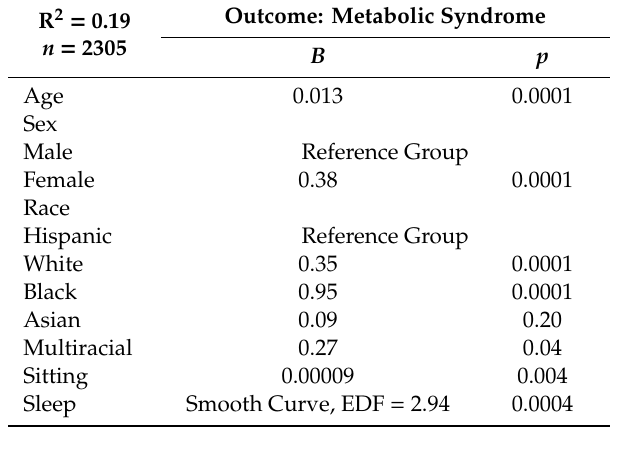
Table 3. Association of metabolic syndrome severity score and independent variables measured by the multivariable generalized additive model 3.